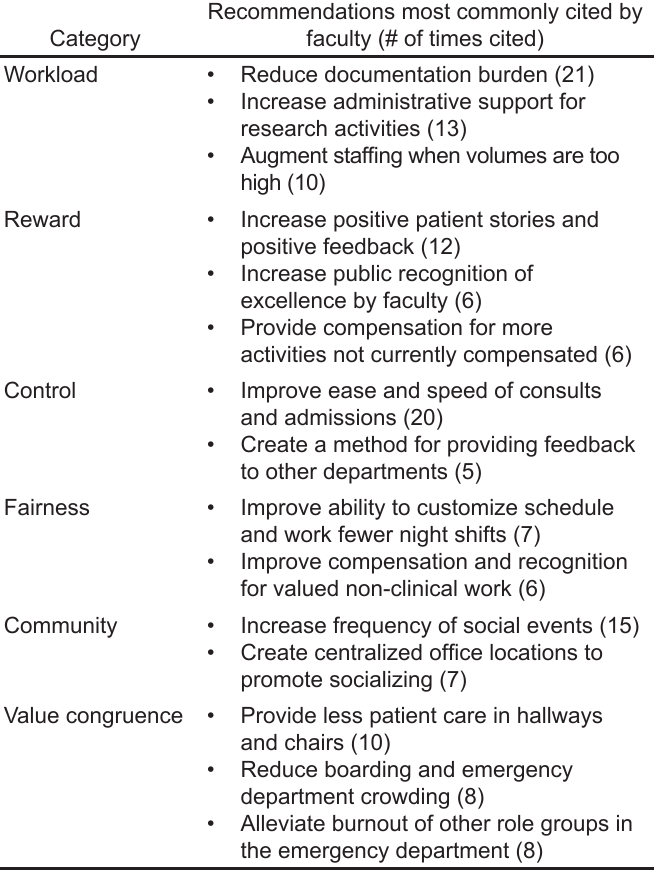
Table 4. Most commonly mentioned interventions identified by faculty for reducing burnout, organized by Maslach-Leiter category, with total number of times mentioned in parentheses.